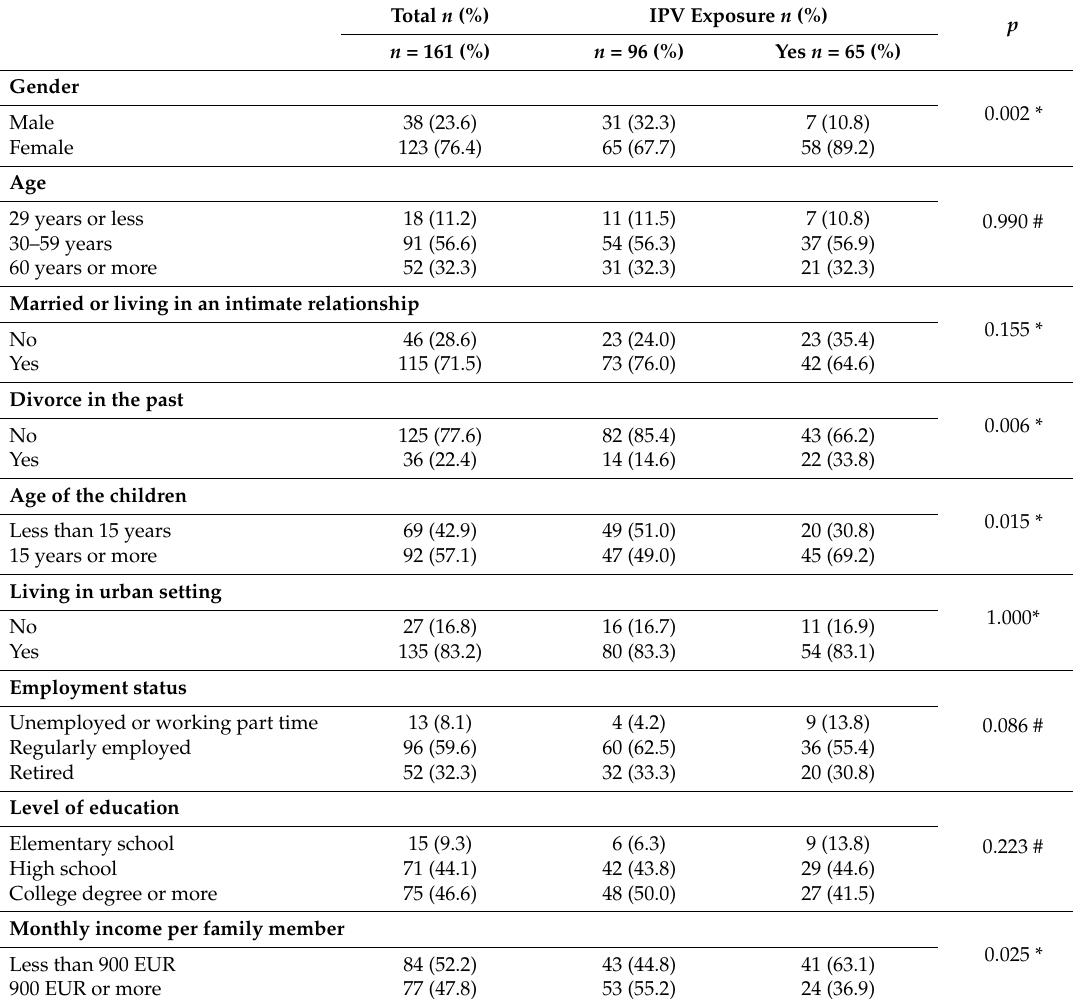
Table 2. Demographics characteristics and IPV exposure of the